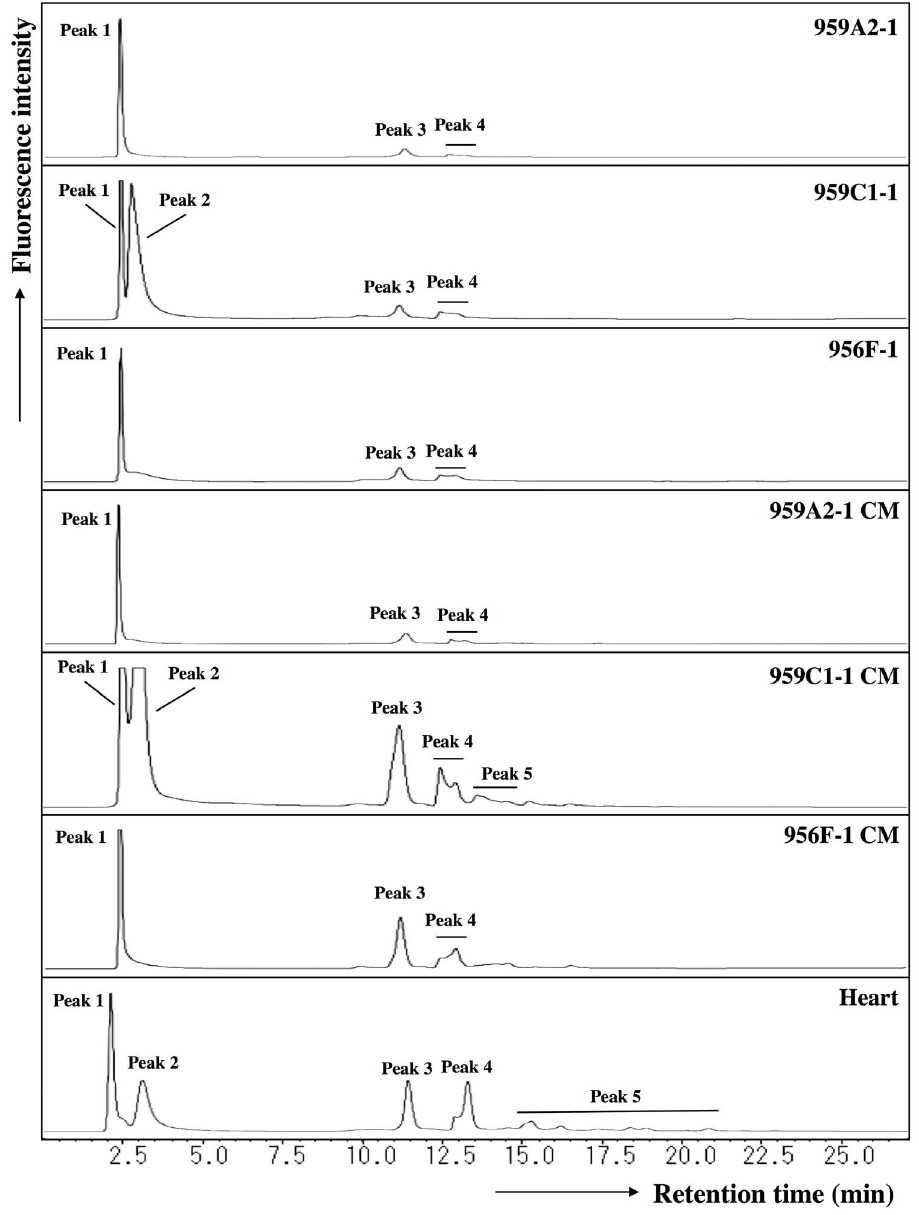
Figure 4. Anion-exchange DEAE elution profiles of PA-glycans. PA-glycans were fractionated according to their sialic acid content as neutral (peak 1), monosialyl (peak 3), and disialyl (peak 4) oligosaccharide fractions. Peaks 2 and 5 represent fractions containing no detectable PA- oligosaccharides.